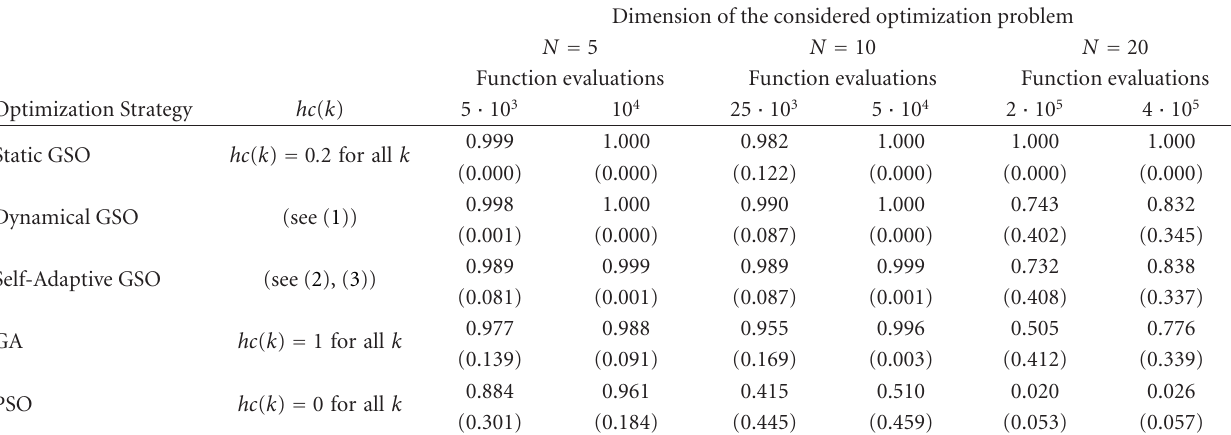
Table 1: Results of the sinc function optimization for di ff erent problem dimensions and rules of variation for the hc parameter during iterations: average final values over 100 independent trials and, in parentheses, their standard deviation σ .